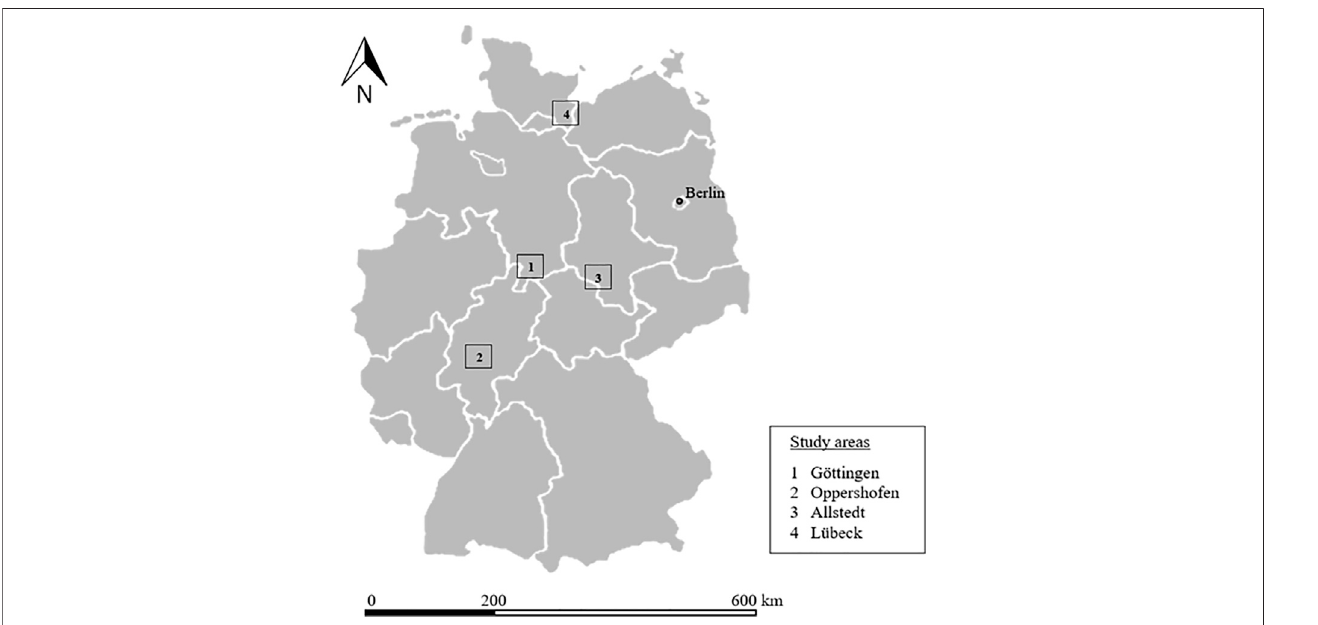
FIGURE 1 | Geographic locations of the study areas located in